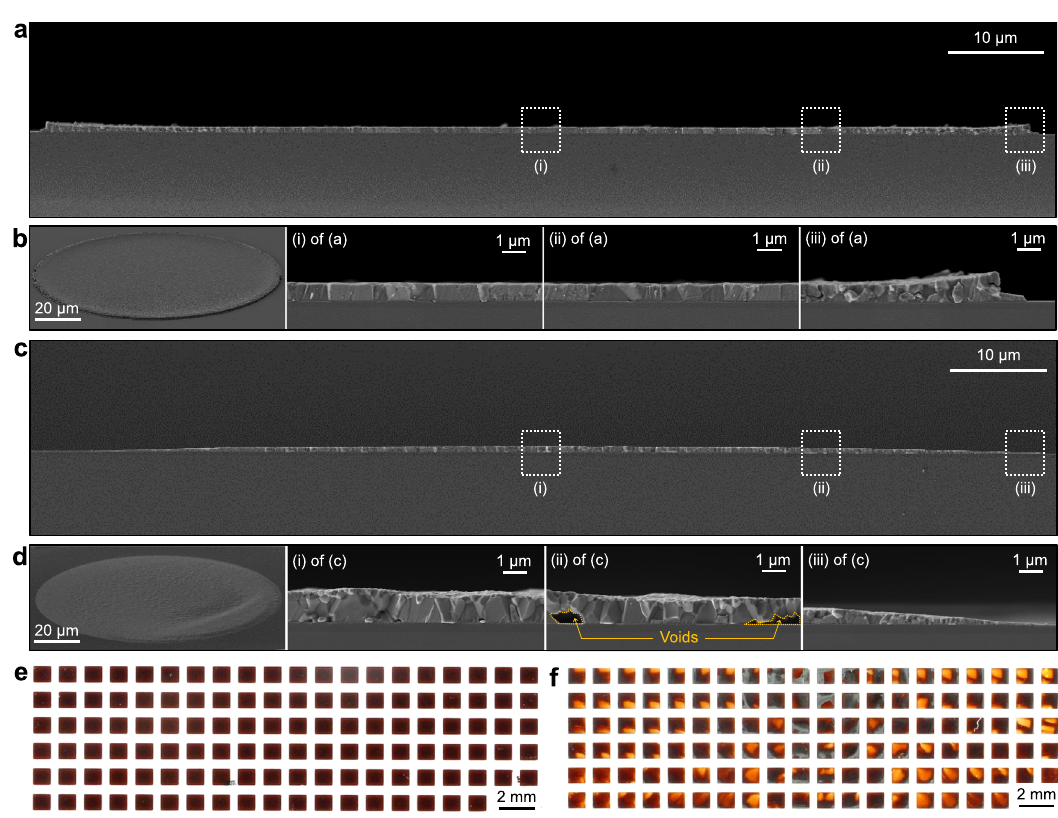
Fig. 2 Perovskite patterns fabricated by the swelling-induced lift-off method and the dewetting method. a Cross-sectional SEM image of a perovskite dot pattern fabricated by the swelling-induced lift-off method. b Tilted view (left frame) and magni fi ed views (other frames) of Fig. 2a. c Cross-sectional SEM image of a perovskite dot pattern fabricated by the dewetting method. d Tilted view (left frame) and magni fi ed views (other frames) of Fig. 2c. e , f Optical camera images that show the array of rectangular perovskite patterns fabricated by the swelling-induced lift-off method ( e ) and the dewetting method ( f